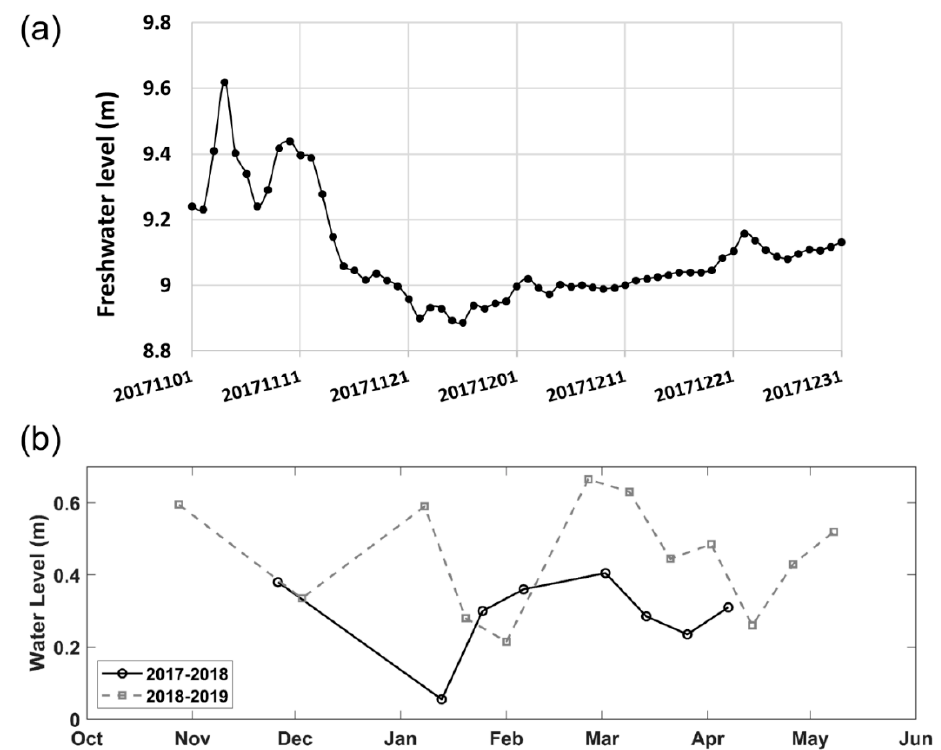
Figure 10. Local daily freshwater level ( a , from the Mackenzie River Reindeer channel (10MC011) located at 69°01 ′ N, 135°30 ′ W) and seawater level ( b , from the Tutoyaktuk station located at 69.44° N, 132.99° W). The seawater level was calculated by averaging the hourly water levels at ascending and descending acquisition times.